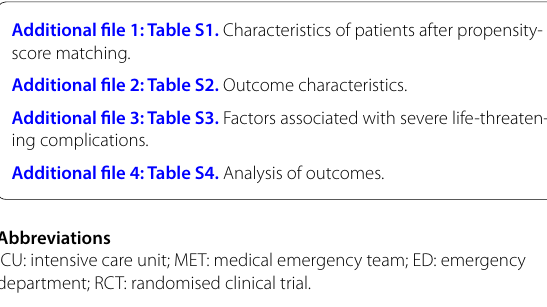
Additional file 1: Table S1. Characteristics of patients after propensity‑ score matching. Additional file 2: Table S2. Outcome characteristics. Additional file 3: Table S3. Factors associated with severe life‑threaten‑ ing complications. Additional file 4: Table S4. Analysis of